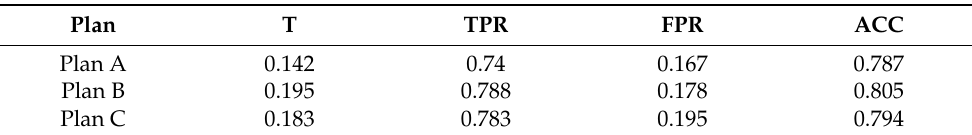
Table 5. DTW threshold and winter wheat extraction results of the combined time series of optimal phenological period combinations in the overall quadrat.